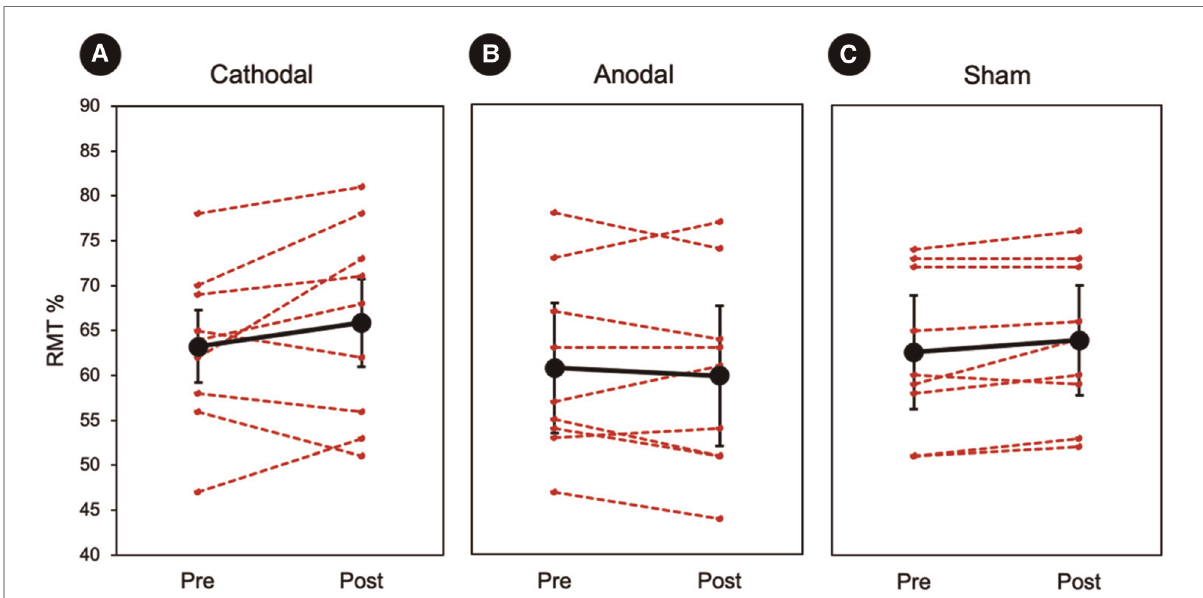
FIGURE 2 Individual resting motor thresholds. ( A – C ) Three randomized tDCS groups. Red represents each individual and the black represents the group average. There was no signi fi cant difference between the session (pre vs. post) or groups (cathodal vs. anodal vs. sham). Error bars represents standard